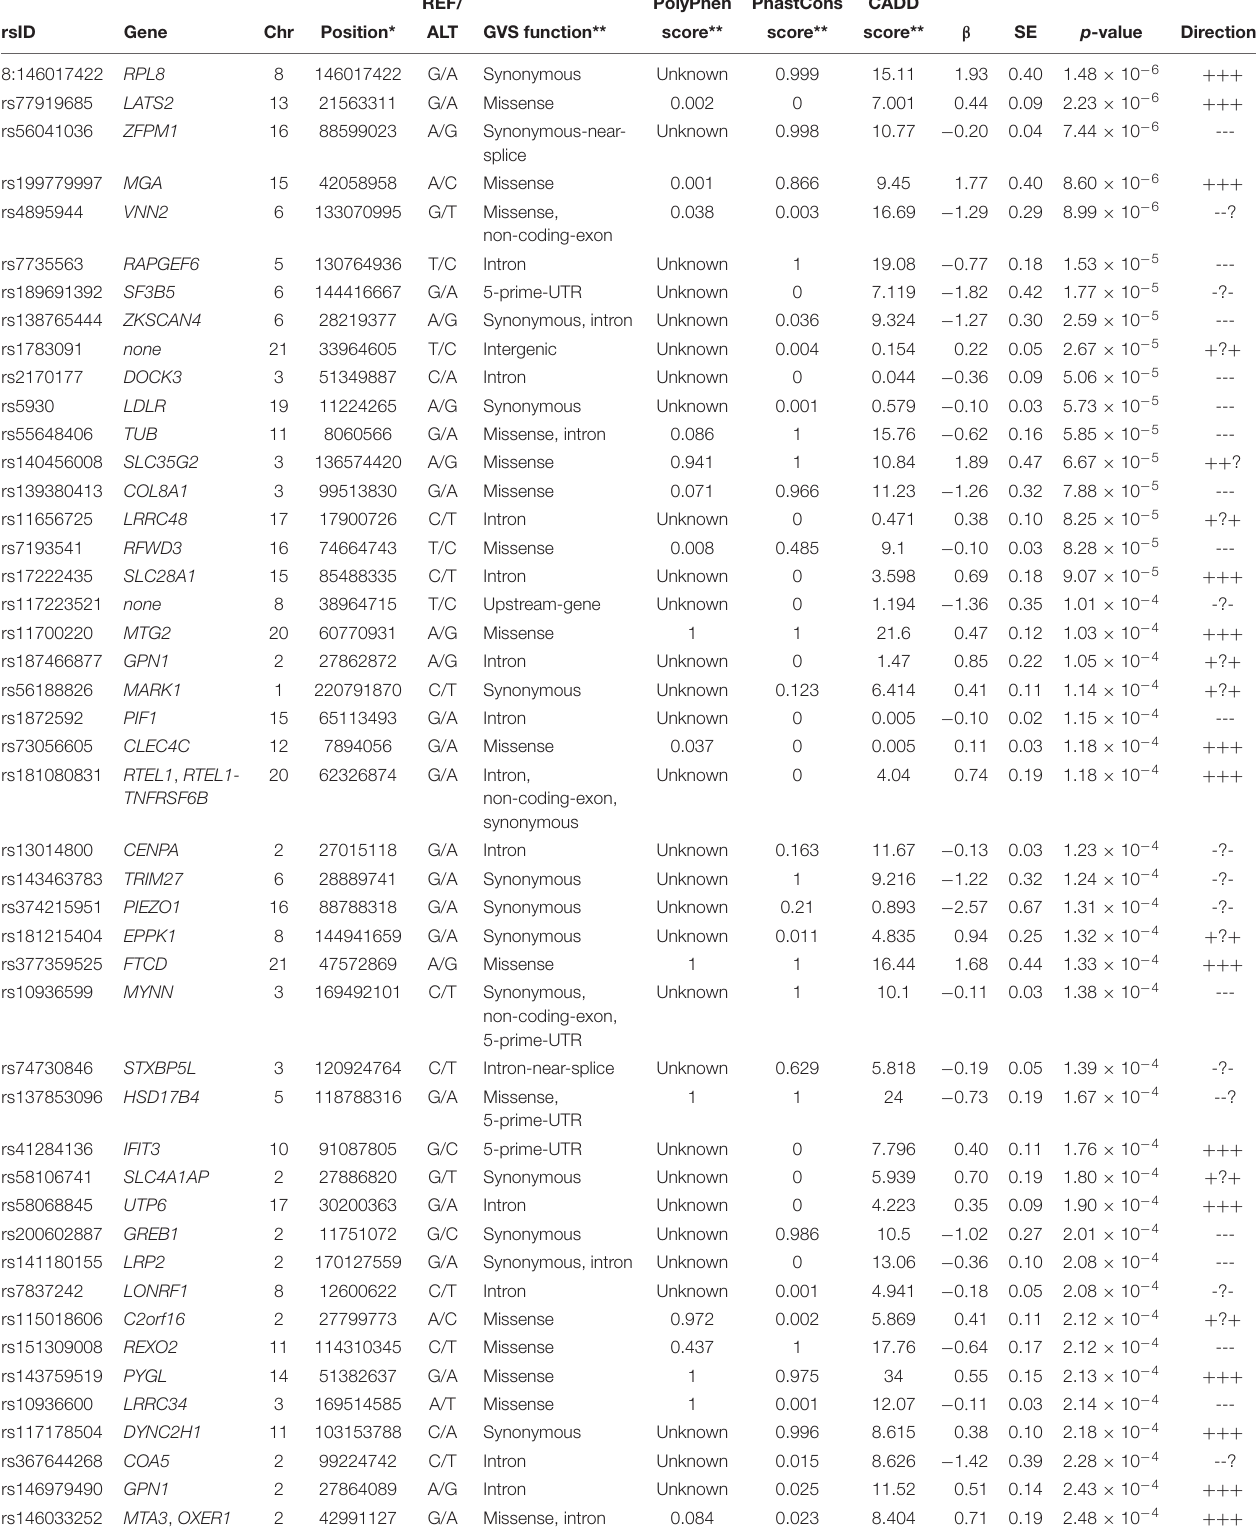
TABLE 4 | Suggestive findings of the meta-analysis ( p -value ≤ 3.02 × 10 − 4 ). REF/ PolyPhen